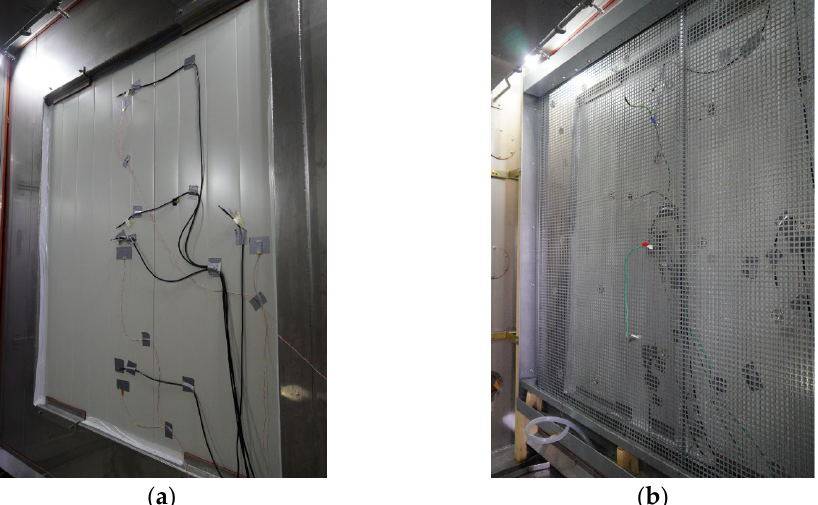
Figure 1. View of the insulated metal panel with the sensor on the exterior surface ( a ) and supporting structure for the outside skin with the top and bottom water gutter ( b ). The top gutter has holes for drainage of water into the vegetation boards.